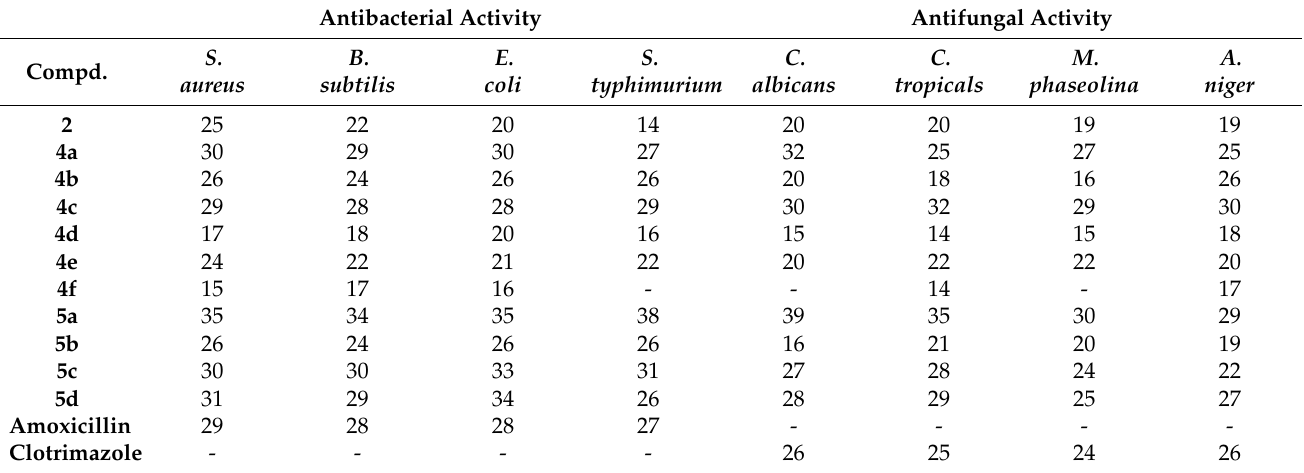
Table 1. In vitro antimicrobial activities of the synthesized quinazolin-4(3 H )-one derivatives repre- sented as the mean diameter of the inhibition zone in mm.